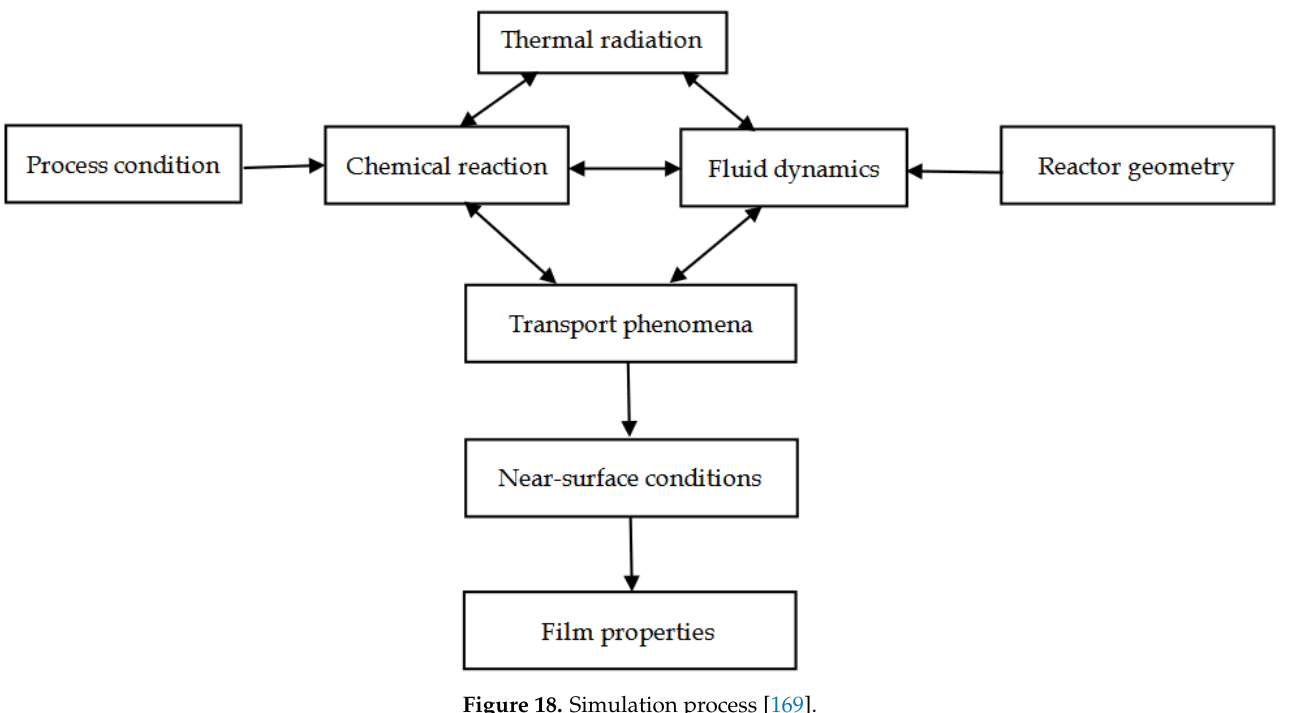
Figure 18. Simulation process [169].